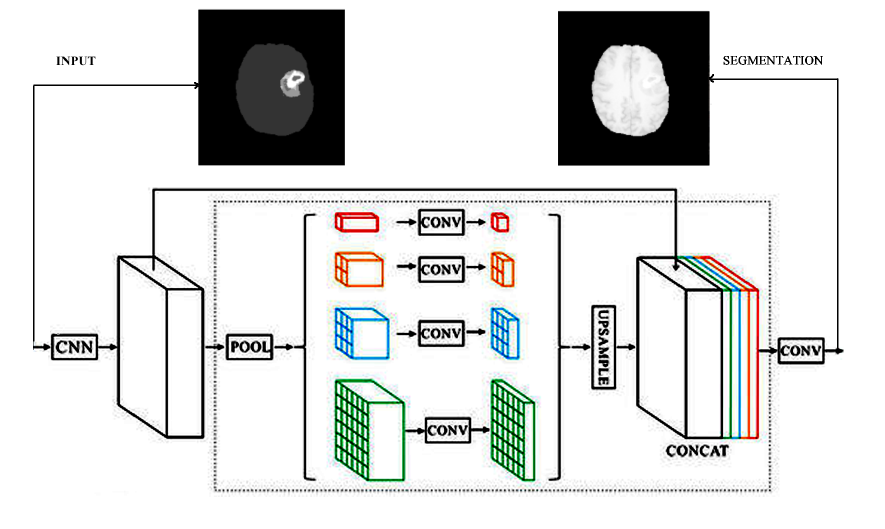
Figure 3. Adapted PSPNet